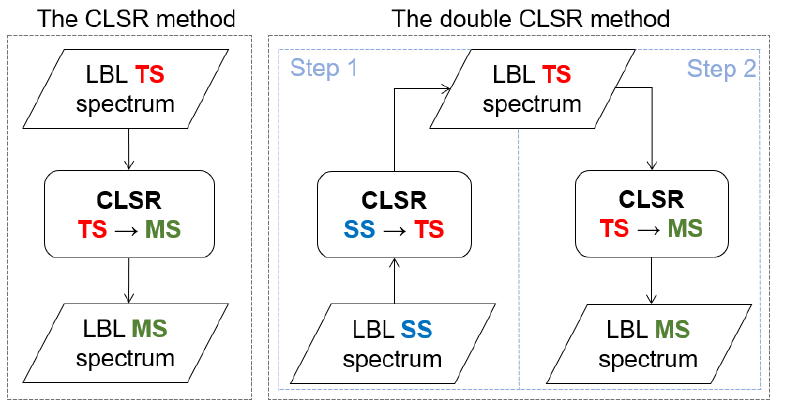
Figure 2. Scheme of the CLSR method vs. the double CLSR